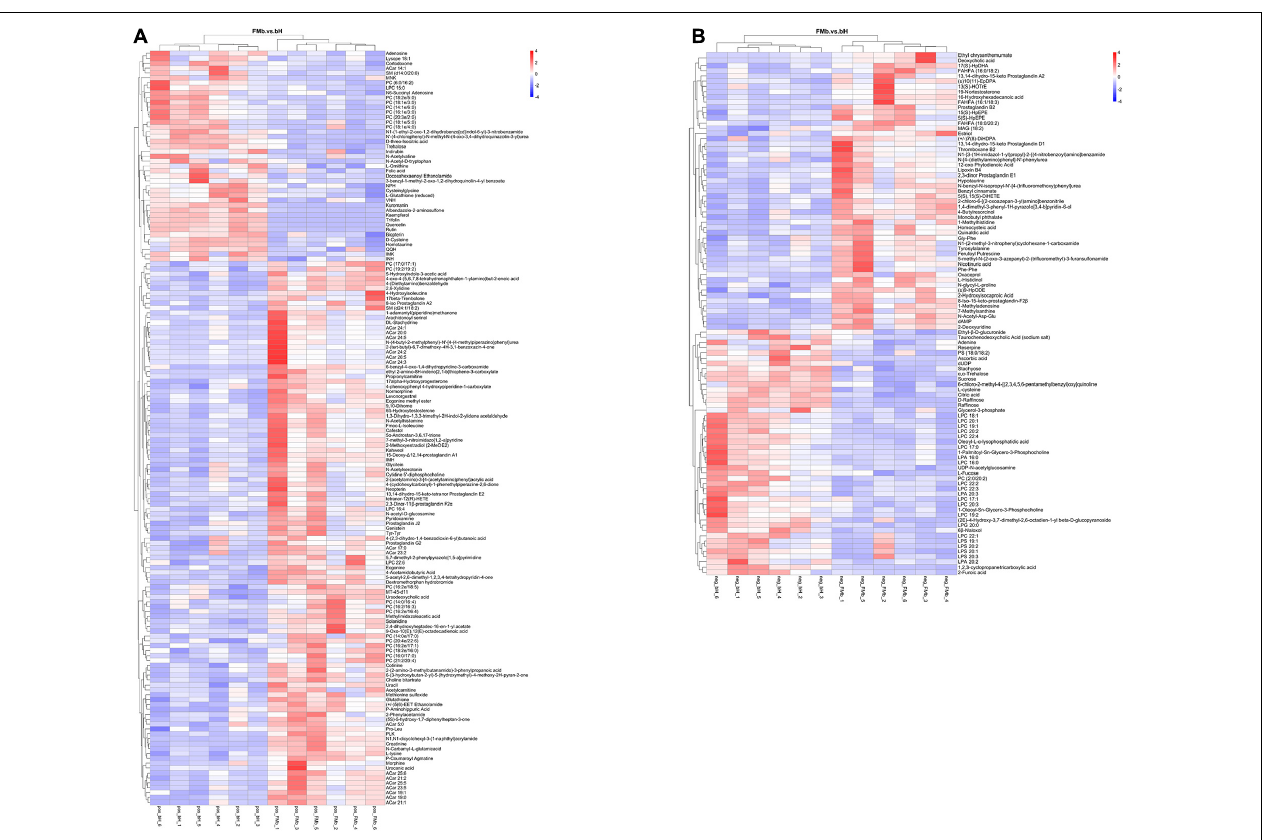
FIGURE 7 | Hierarchical clustering analysis of the DMs in FMb vs. bH: positive (A) and negative (B) ions. Red and blue indicate that the DMs were upregulated and downregulated, respectively.